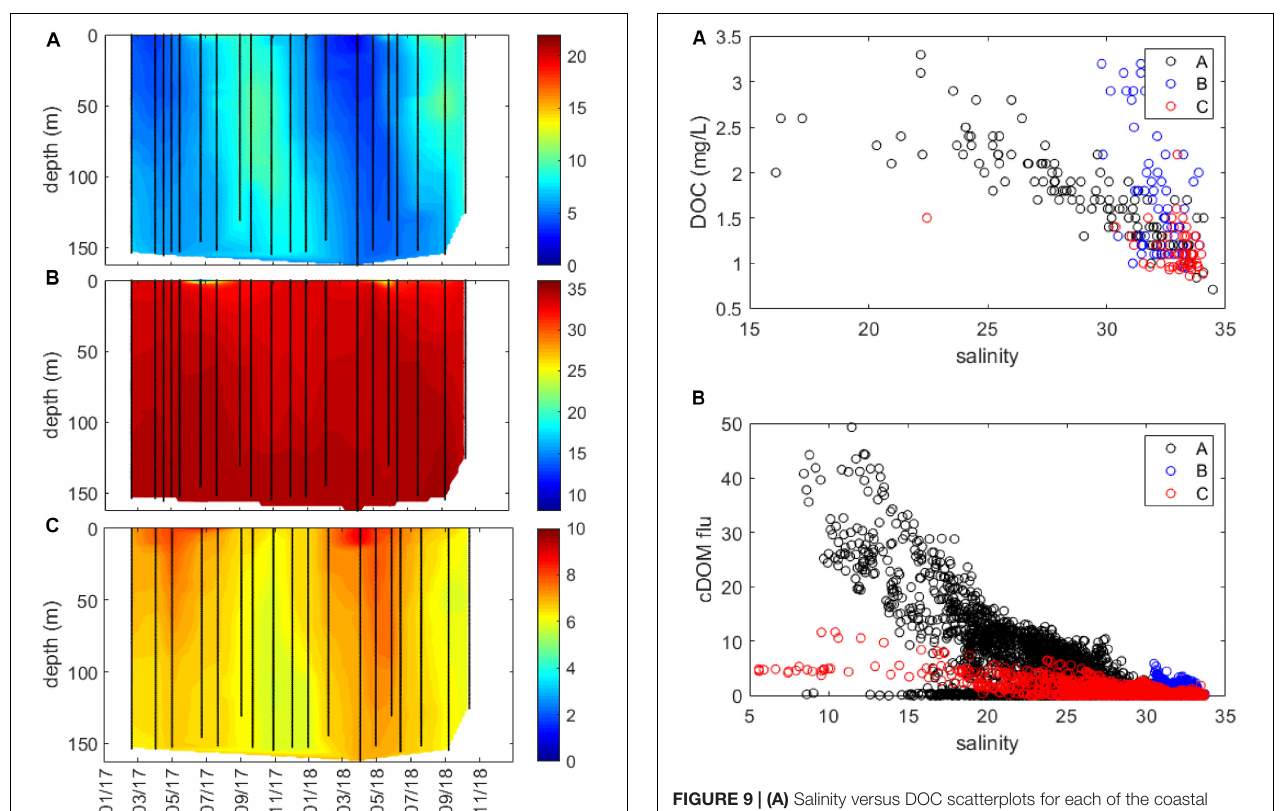
FIGURE 9 | (A) Salinity versus DOC scatterplots for each of the coastal stations in the three study regions (data from 0 to 30 m) and (B) salinity versus cDOM fluorescence scatter plots for the underway ship observation transect in the three study regions (data from ∼ 5